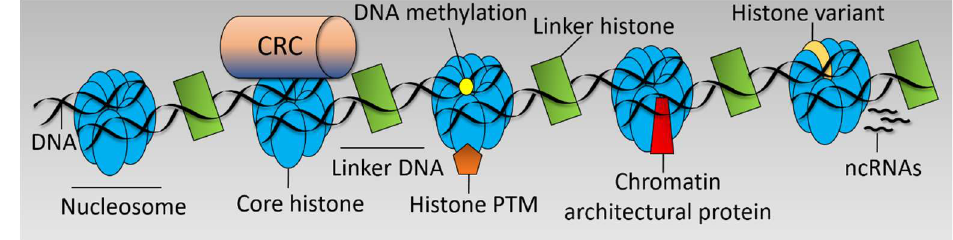
Figure 1. Chromatin structure. Simplified linear diagram of chromatin highlighting the main mechanisms by which chromatin structure is regulated. Chromatin Remodeller Complex (CRC), post translational modification (PTM), and non-coding RNAs, (ncRNAs).